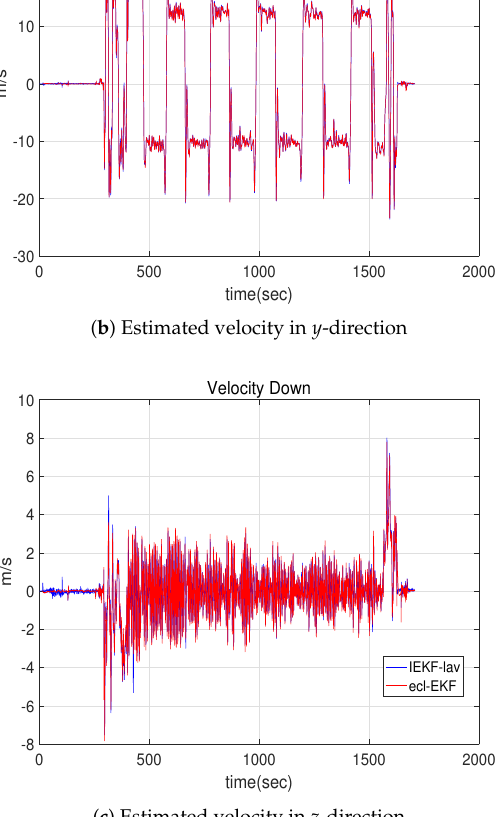
Figure 4. Velocities estimated by IEKF-lav and